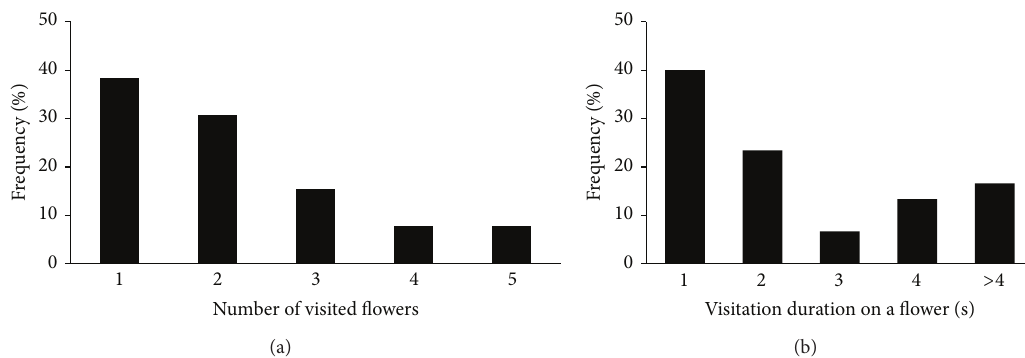
Figure 3: Visitations on Calypso bulbosa flowers by bumblebee queens within study plots in 2007. Frequency distribution for (a) number of visited flowers ( 𝑁 = 13 bumblebees) and (b) visitation duration in seconds on a single flower ( 𝑁 = 30 flowers).